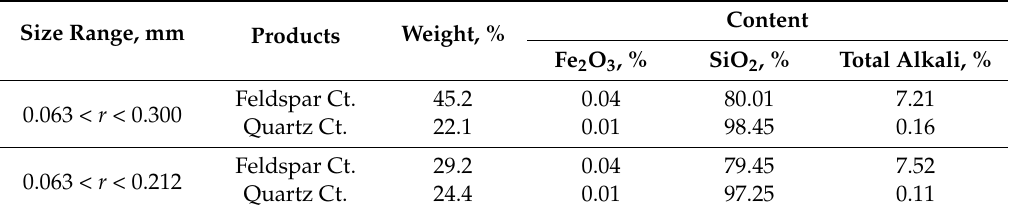
Table 2. The effect of particle size on flotation (Ct: concentrate).